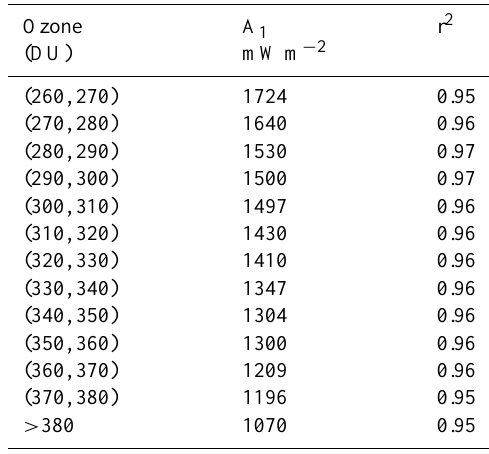
Table 3. Coefficient A 1 for different intervals of ozone columnar